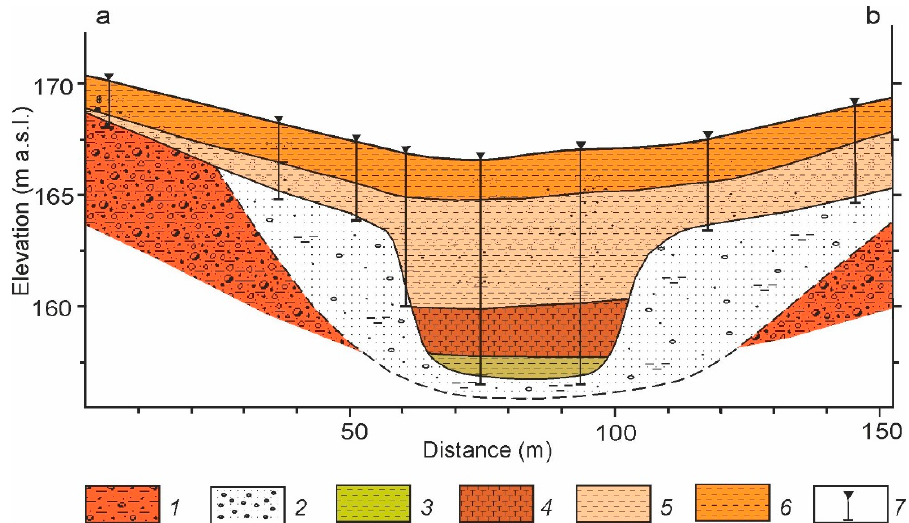
Figure 6. The lithological structure of the Senokosnaya Lozhbina. Keys: 1—MIS 6 moraine, 2— glaciofluvial sand and gravel, 3—brown-grey loam, 4—peat, 5—slopewash sand and loam, 6—mantle loam,